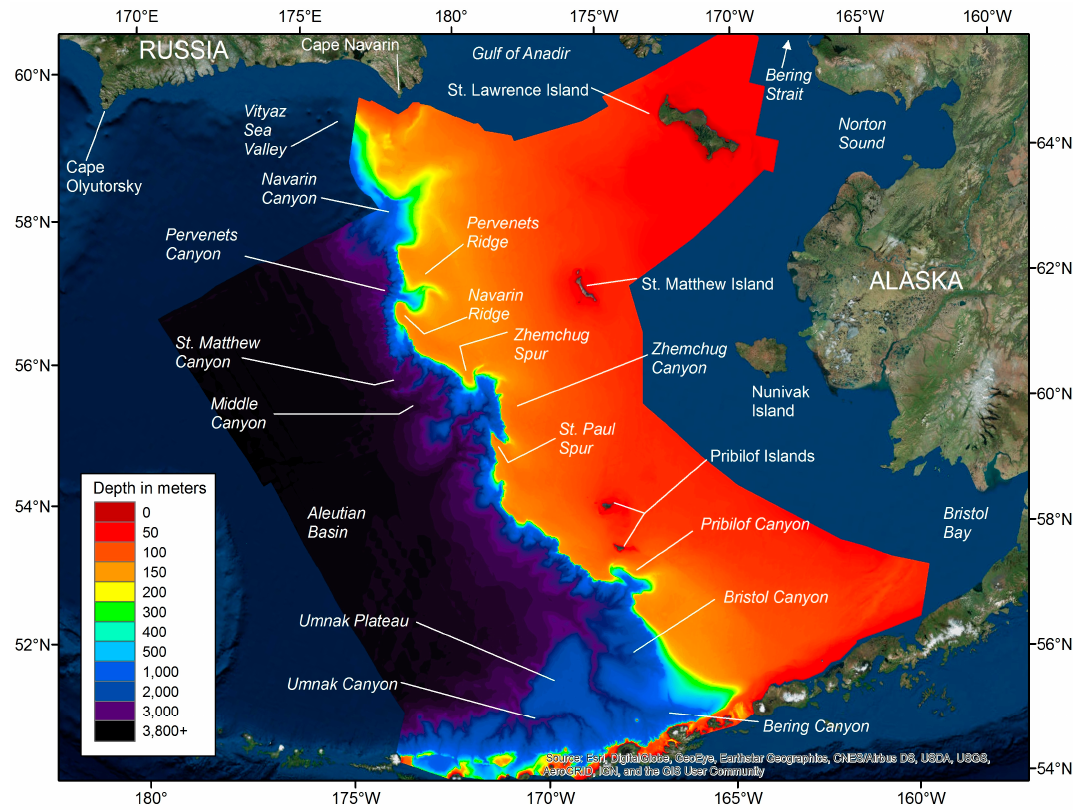
Figure 5. Bathymetry of the eastern Bering Sea slope.